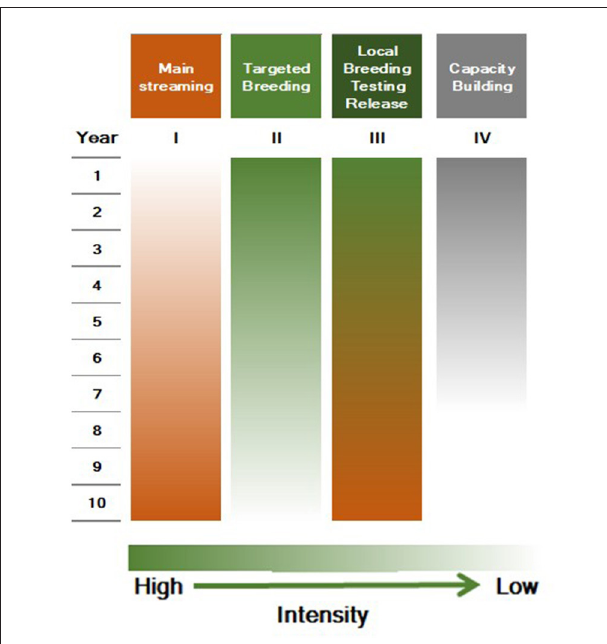
FIGURE 4 | Proposed strategy and timeline for a gradual shift from targeted breeding to mainstreaming.